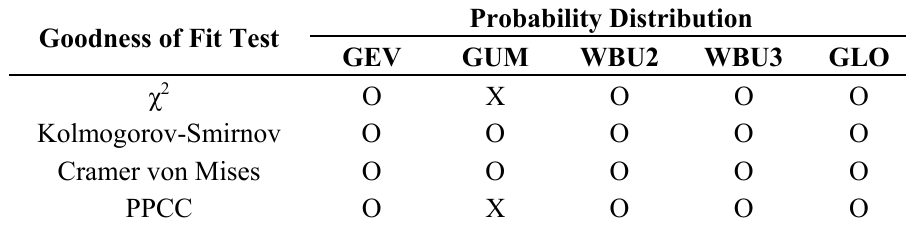
Table 7. The results of the goodness of fit tests for the applied probability models. GEV: Generalized extreme value; GUM: Gumbel; WBU2: 2-parameter Weibull; WBU3: 3-parameter Weibull; GLO: generalized logistic; PPCC: probability plot correlation